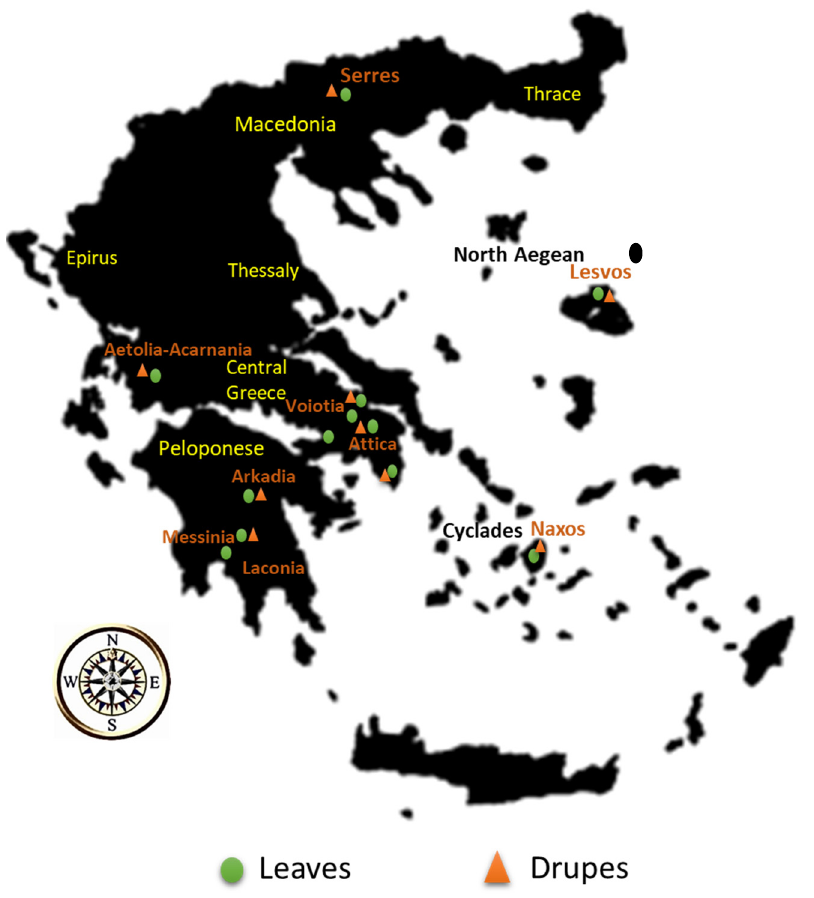
Figure 1. Geographical origin of olive leaves and drupes.